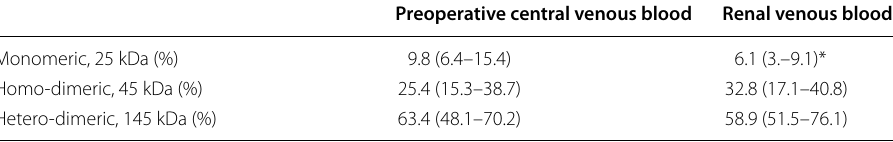
Data are median (interquartile range). * p < 0.01 for preoperative central venous blood vs. renal venous blood (Wilcoxon signed‑rank test). NGAL neutrophil gelatinase‑associated